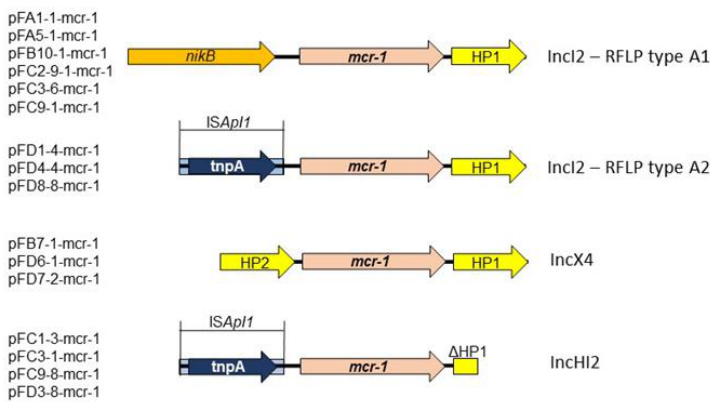
Figure 2. Genetic surrounding of the mcr-1 gene in various plasmids. Members of a single E. coli ST (ST1196) carried plasmids of two different incompati- bility types, i.e., IncI2 (strain FC2-9-1) or IncX4 (strain (FB7-1), only. Beyond E. coli FB7-1, the IncX4 plasmid was also present in the two K. pneumoniae and in the S. minnesota strains (Supplementary Table S1).